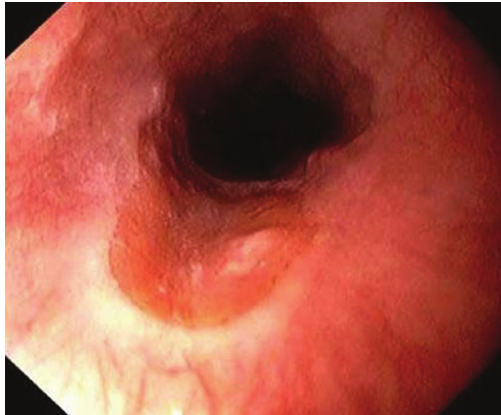
Figure 3: Endoscopic appearance of an annular inlet patch from a di ff erent patient. The ectopic gastric mucosa is salmon-coloured and velvety and is easily distinguished from the normal grey-white esophageal epithelium. The raised border of the lesion corresponds to the radiological findings of esophageal indentations. Image reprinted with permission from Medscape.com, 2009. Available at: